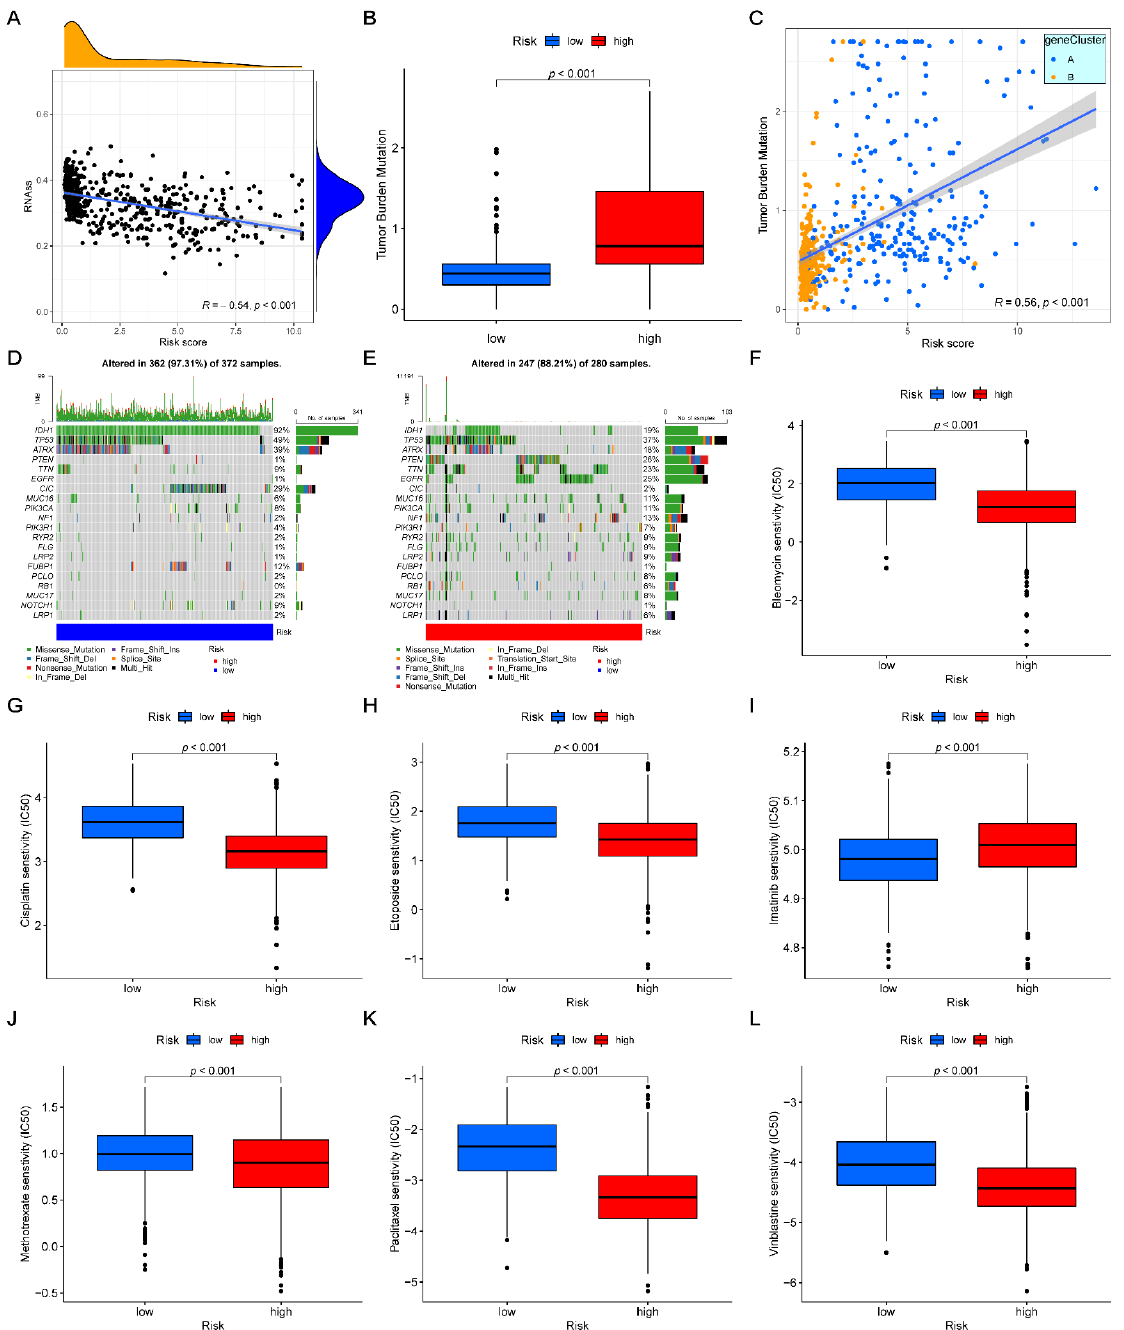
Figure 7. Overall evaluations of our risk scores in glioma. ( A ) Correlations between risk scores and CSC index. ( B ) Difference in the TMB of high- and low-risk groups. ( C ) Correlations of risk scores and TMB. ( D , E ) Somatic mutation analyses in two risk groups. ( F – L ) Correlations between the different risk groups and sensitivity of chemotherapeutic agents. CSC, cancer stem cell; TMB, tumor mutation burden.